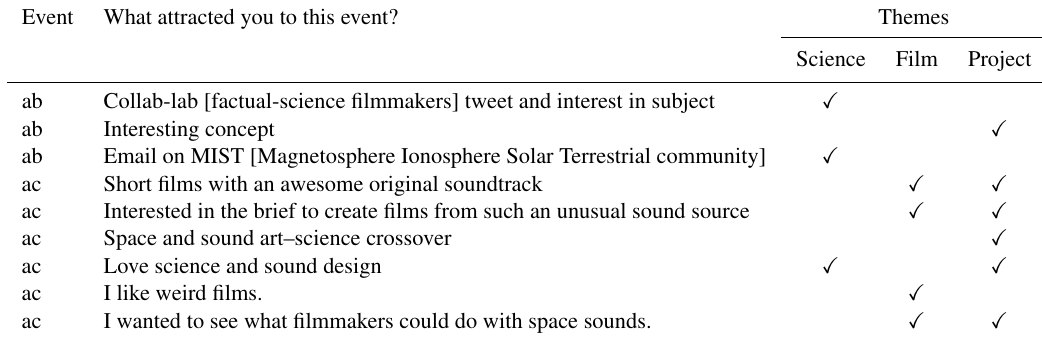
Table B2. Audiences motivations for attending SSFX events.